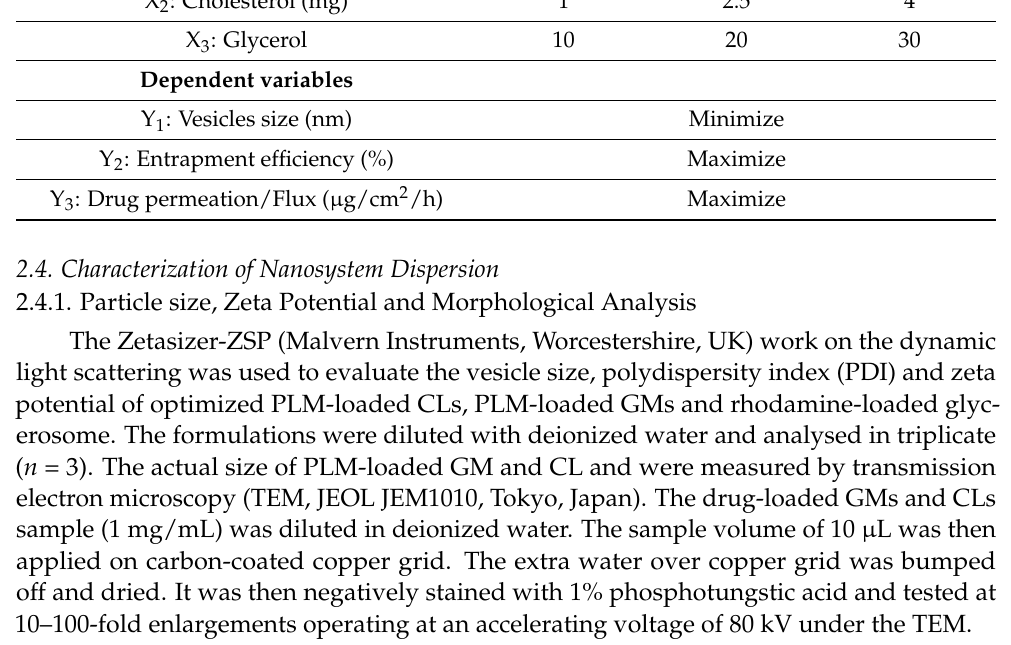
Table 1. Box–Behnken design experimental dependent and independent variables with levels (low, medium and high) employed in the fabrication of PLM-loaded GMs. Level Used Independent Variables Low ( − 1) Medium (0) High